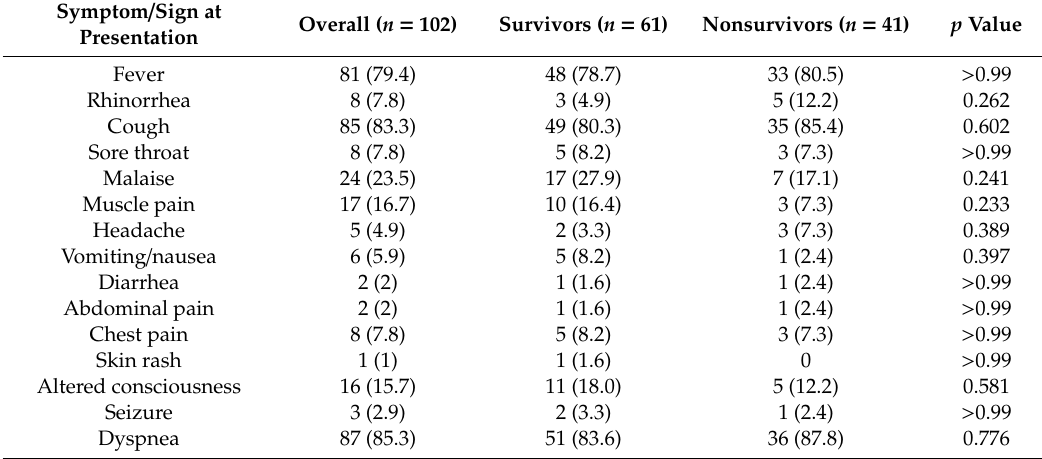
Table 2. Symptom / signs of patients with severe